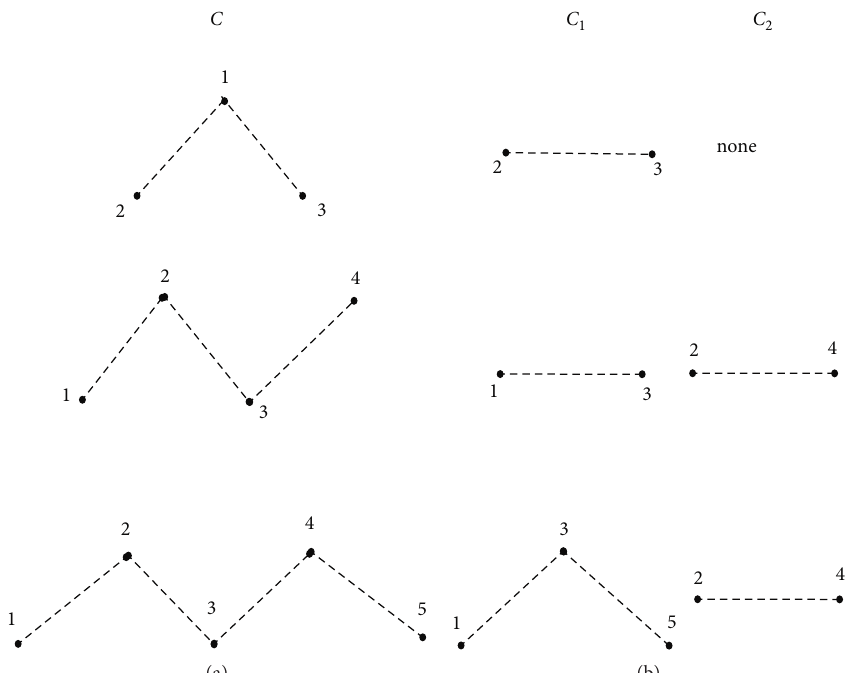
Figure 6: (a) A P section of length less than 5 in cycle C of Σ . (b) The corresponding P sections in cycle C